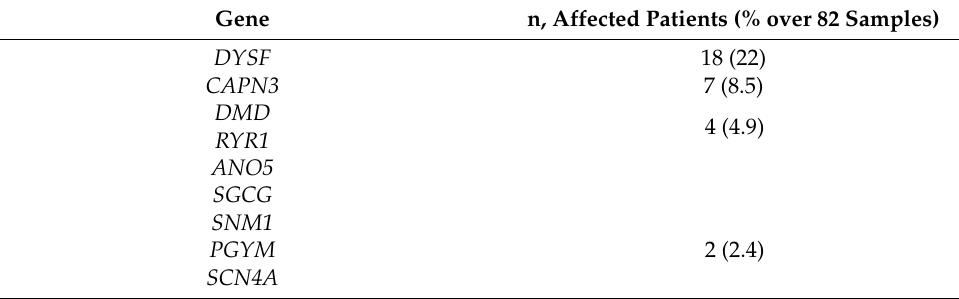
Table 2. Number of patients with definite genetic diagnosis by gene.